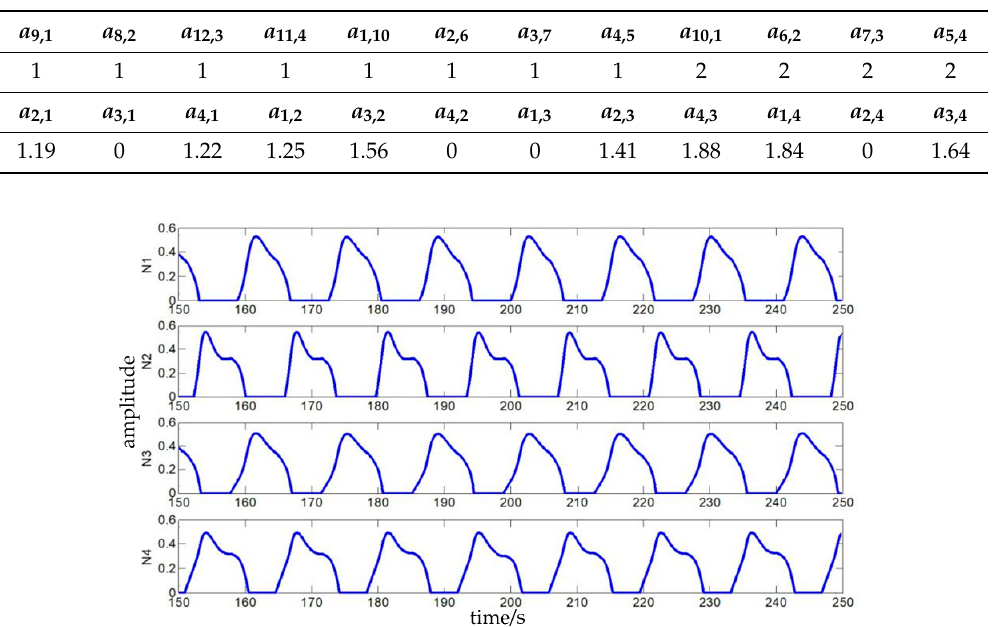
Figure 16. Output of self-growing network in trot gait.